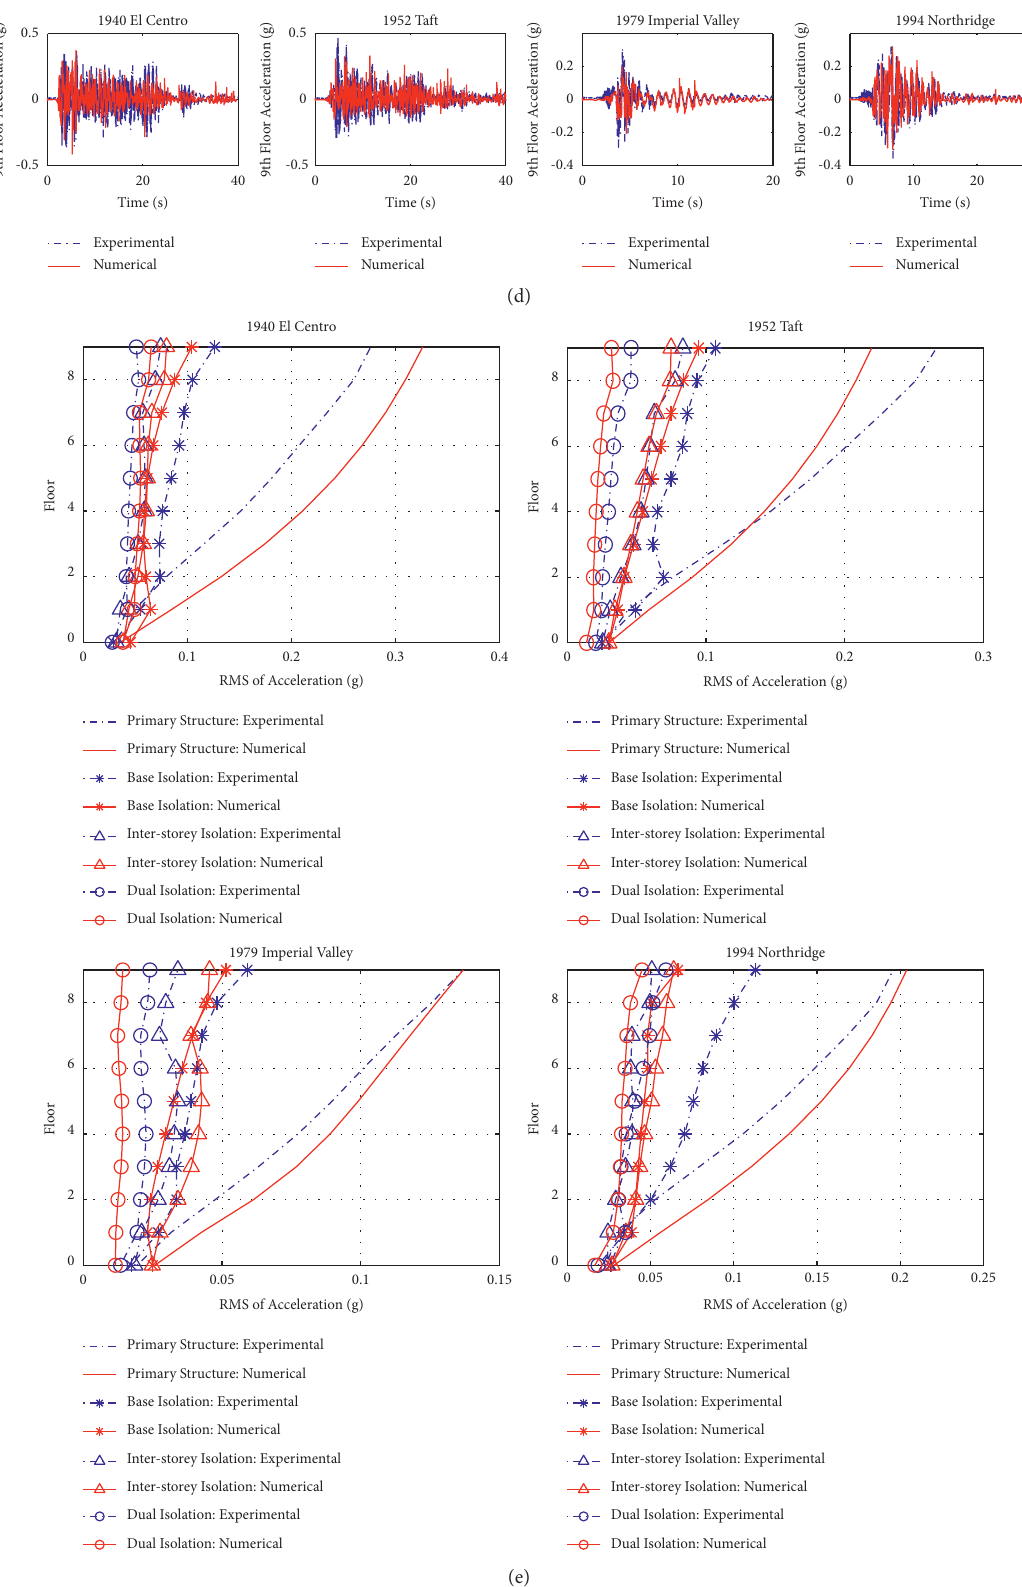
Figure 17: Comparison of experimental and numerical results in (a) primary structure; (b) FPS base isolation structure; (c) FPS inter-storey isolation structure; (d) FPS dual isolation structure; and (e) RMS values of floor